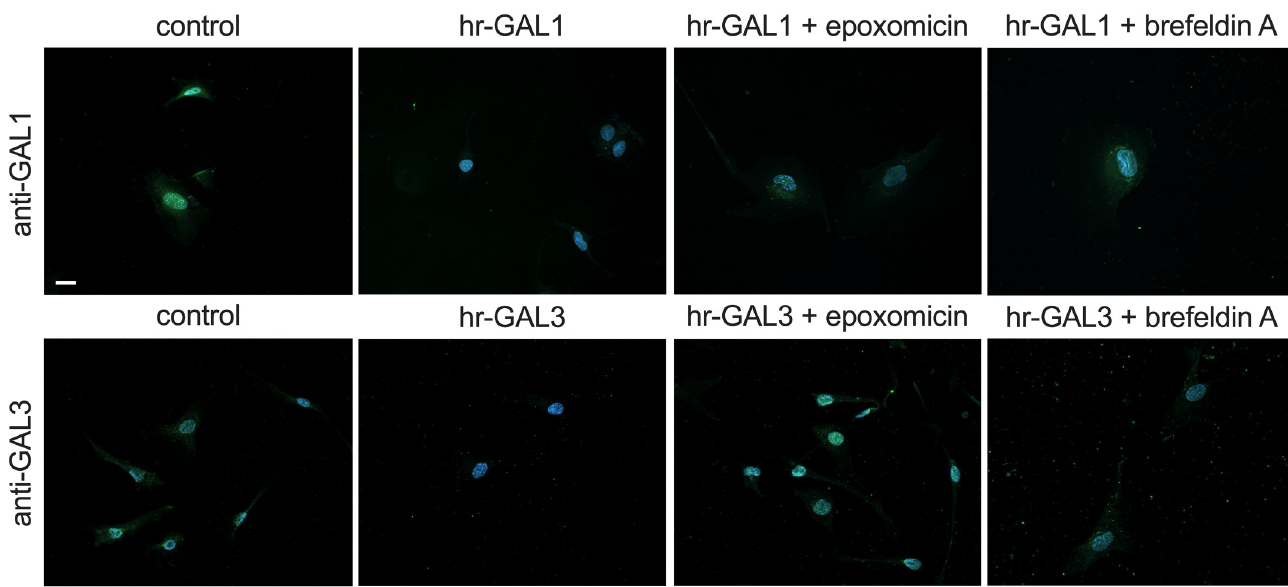
Fig 2. Hr-GAL1 and 3 decreases intracellular galectin-1 and -3 level via exocytosis and proteasomal degradation. Immunostaining of HRMEC for galectin-1 and -3 after incubation with 120 μ g/ml hr-GAL1 or 3 with or without 5 μ M epoxomicin, an inhibitor of proteasomal degradation, or 10 μ M brefeldin A, an inhibitor of exocytosis, for 12 h. Magnification bar, 20 μ m; blue, Hoechst